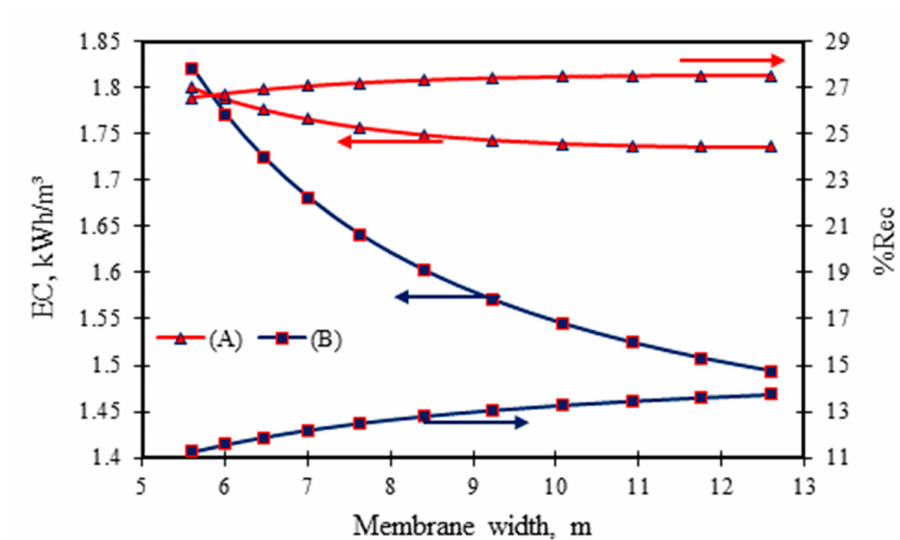
Figure 6. Influence of membrane design width on permeate recovery and energy consumption at fixed membrane area and feed channel height (operating parameters: ( A ) 6.548 × 10 − 3 kmol/m 3 , 2.583 × 10 − 4 m 3 /s, 13.58 atm and 31.5 ◦ C, and ( B ) 0.819 × 10 − 3 kmol/m 3 , 2.166 × 10 − 4 m 3 /s, 5.83 atm, and 32.5 ◦